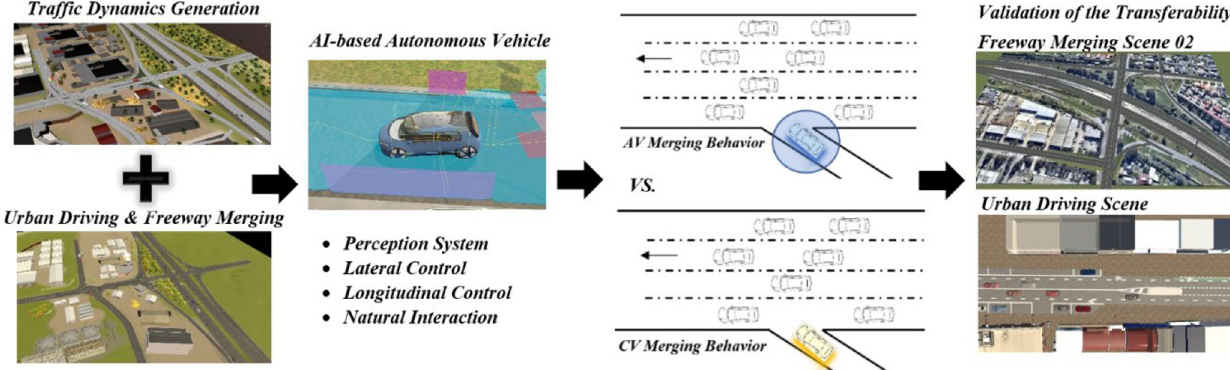
Figure 6 The basic work fl ow of the AV development and evaluation (AV: autonomous vehicle; CV: conventional